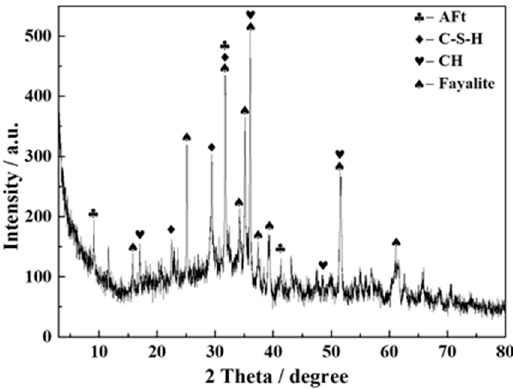
Figure 6. XRD pattern of T4-2 sample after being cured for 28 days.